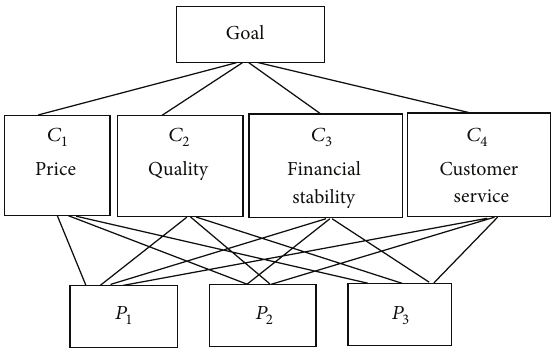
Figure 5: Hierarchy structure of Example